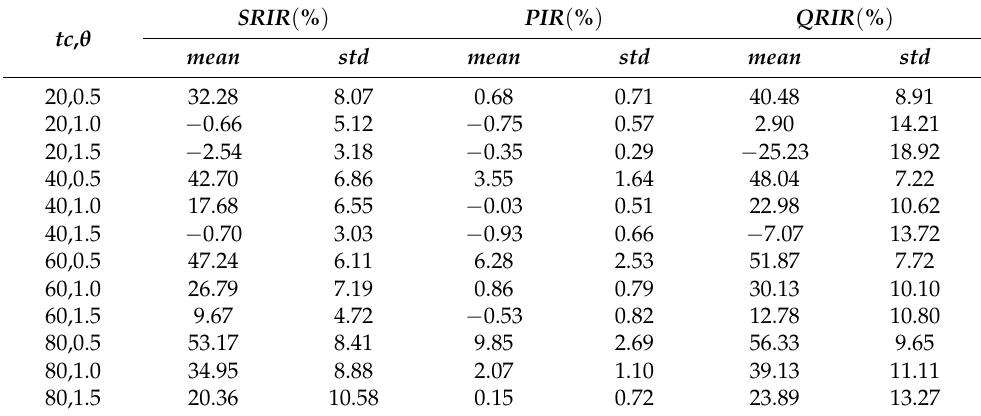
Table 5. Relative difference between δ p and δ pm